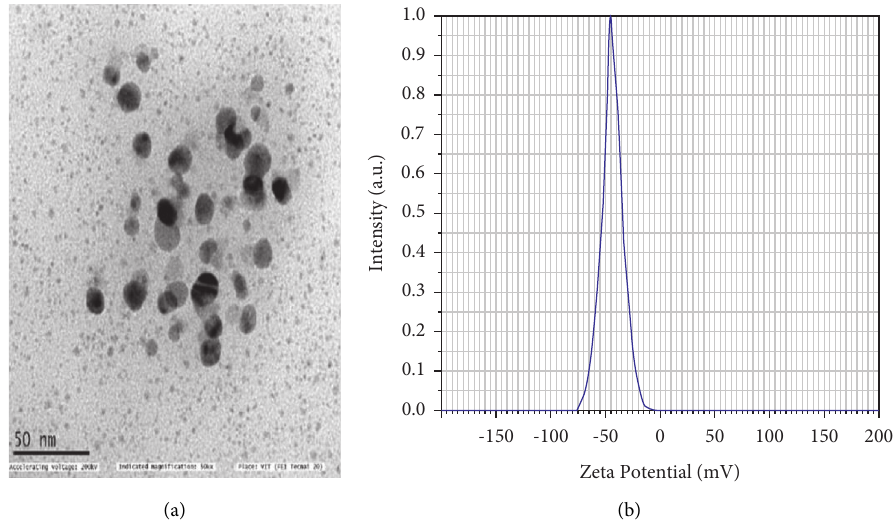
Figure 4: (a) HRTEM used size of image and (b) DLS used stable of TiO